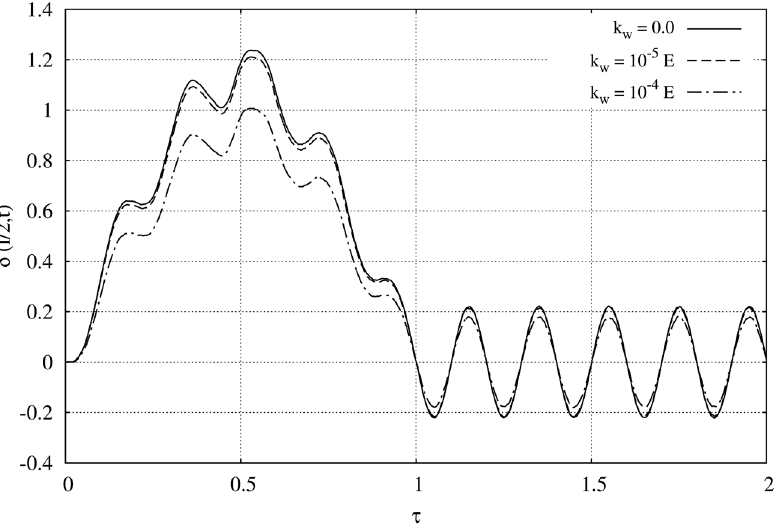
= 10 -5 E , 1 µ = nm, P / g = w